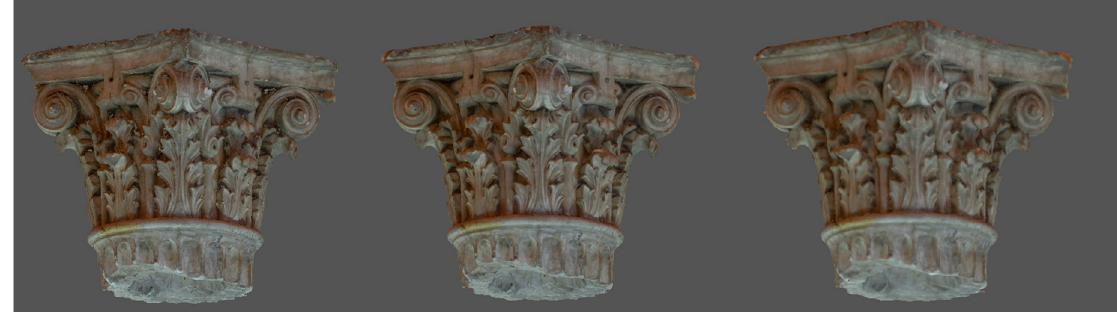
Figure 8. Scalar field mapping of Hausdorff distances for dataset 4 photogrammetric results. Deviation between the ARP mesh and the AMP mesh ( left ), deviation between the ARP mesh and the FZA mesh ( center ), deviation between the ARP and the P4D mesh ( right ); maximum visualized distance: 1 cm.